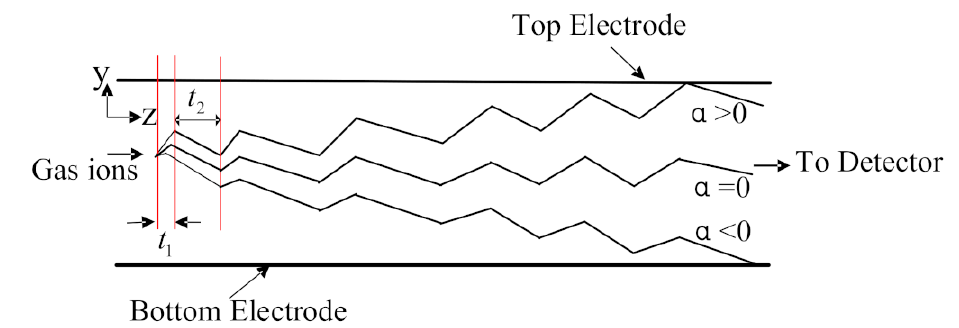
Figure 5. The trajectory of ions in an asymmetric high and low electric field.